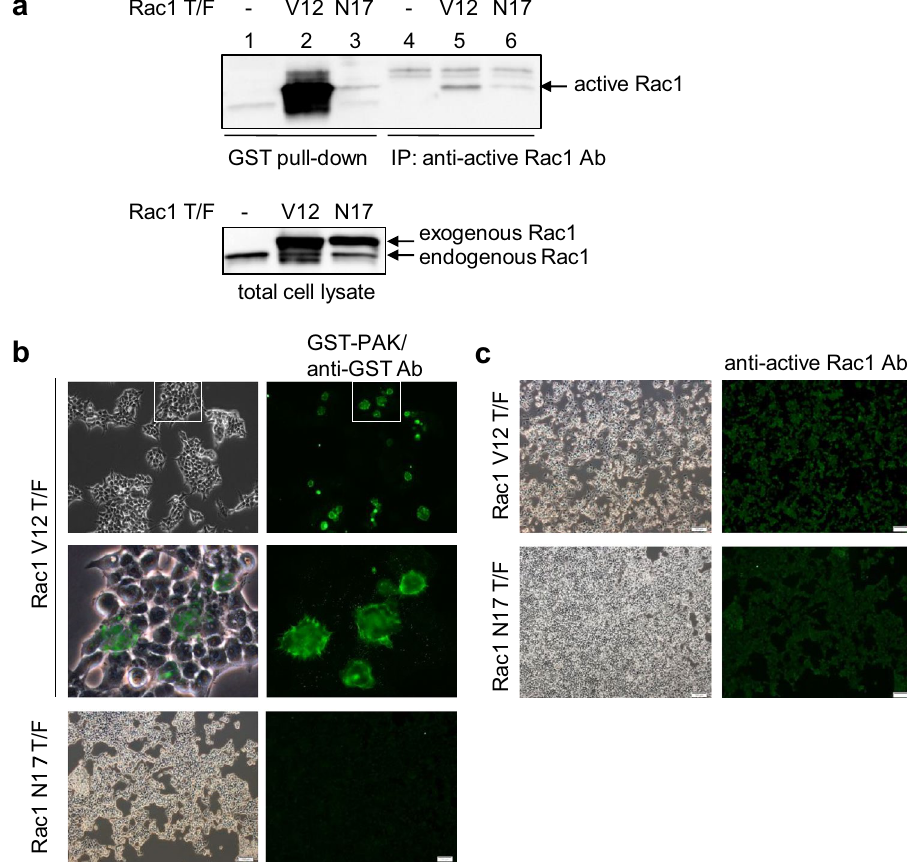
Figure 1. Comparison between the GST-PAK-RBD probe and anti-active Rac1 antibody for active Rac1 detection. 293T cells were transiently transfected with or without expression vectors of pCXN2-Flag-Rac1V12 or pCXN2-Flag-Rac1N17. ( a ) GTP-bound activated Rac1 (Rac1-GTP) was detected by GST pull-down assay using GST-PAK-RBD (Lanes 1–3) or immunoprecipitation using anti-active Rac1 antibody (Ab) (New East, Lanes 4–6), followed by immunoblotting (IB) of Rac1. The expression levels of total Rac1 were examined using an anti-Rac1 Ab (lower). ( b , c ) 293T cells with enforced Rac1V12 or Rac1N17 were subjected to immunofluorescence analysis using GST-PAK-RBD/anti-GST Ab ( b ) and anti-active Rac1 Ab ( c ). In ( b ), high magnification images of the areas surrounded by squares are shown lower. Green fluorescence image representing Rac1V12-expressing cells (right) and merged image to phase-contrast micrograph (left) are